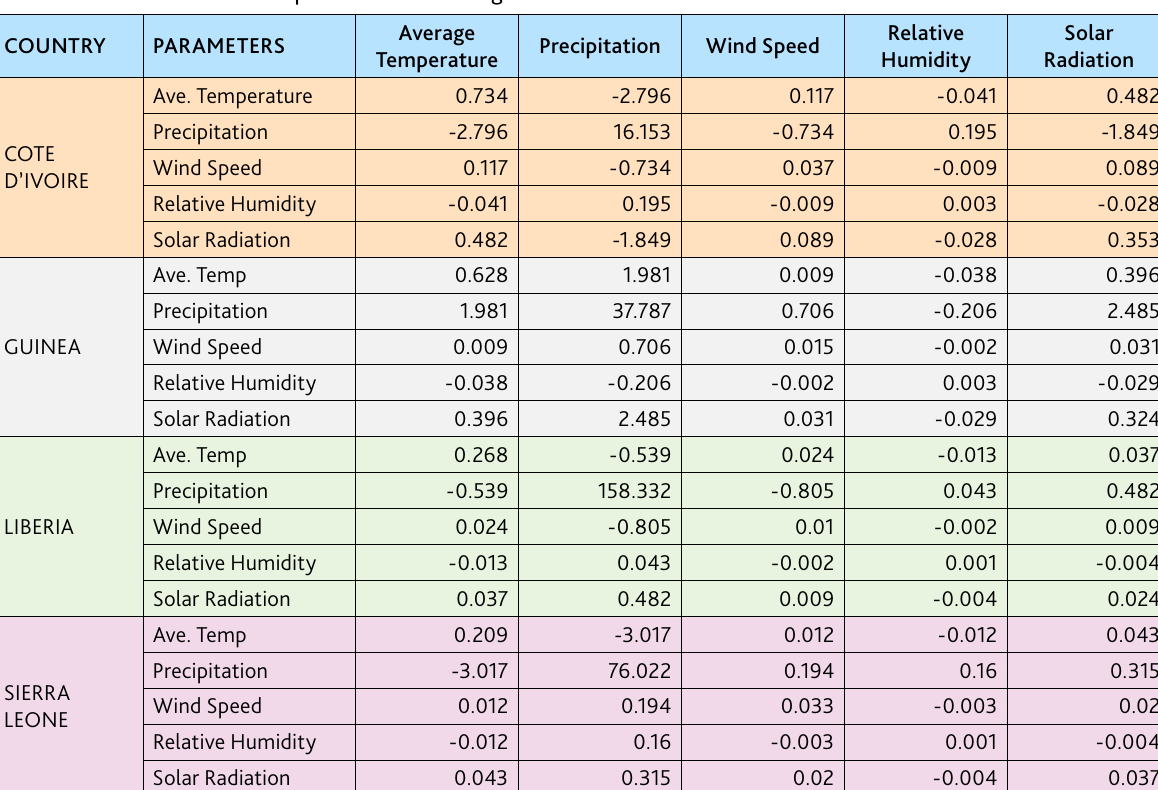
Table 6. Covariance Matrix for parameters in the region